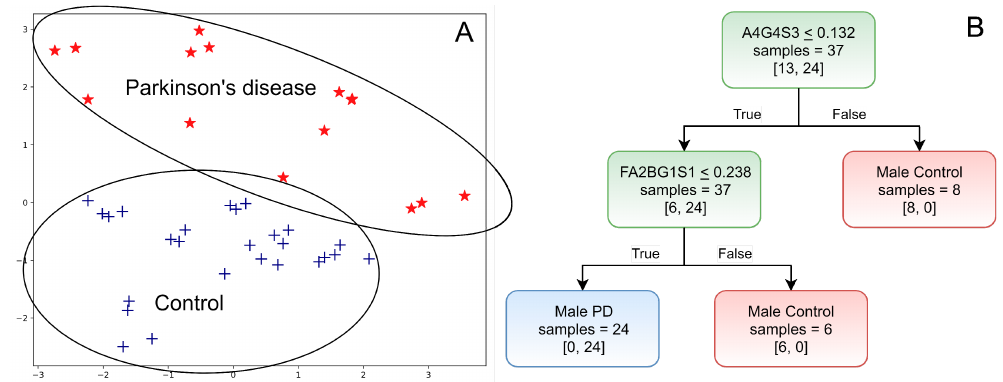
Figure 3. ( A ) Classification of male patients using recursive feature elimination and ( B ) the generated